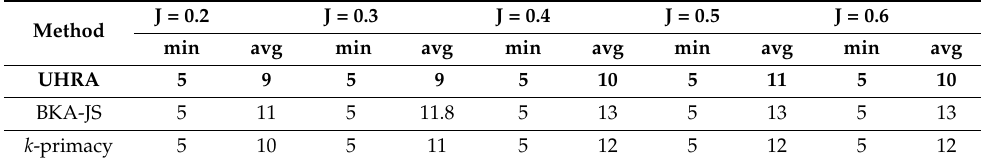
Table 4. The size (min, avg) of QI groups on Adult dataset with t = 0.5 and k = 5.